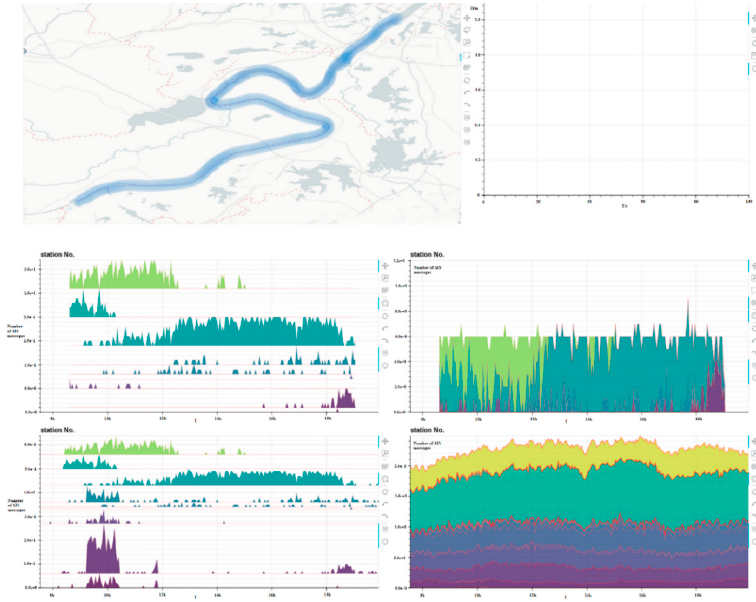
Figure 17. Stack graph of AIS data report.